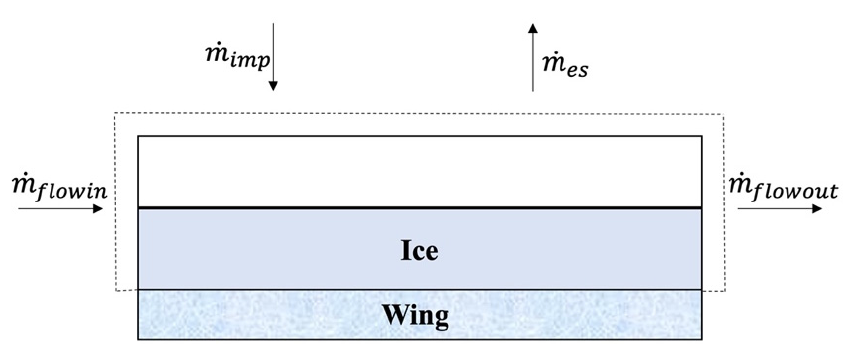
Figure 4. Mass balance in the control volume [14].